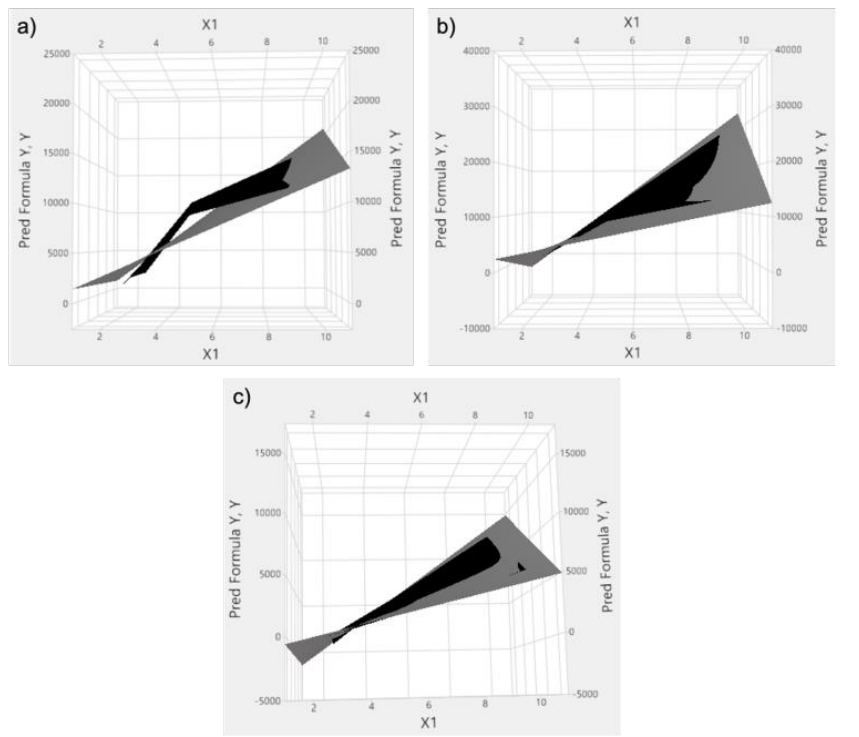
At lower Bis concentrations, the regression model was dominated by the effects of AAm (X 1 ) and SiNP (X 3 ) at a significance threshold of 0.1 ( p = 0.1), as deviation from linearity is characterized by an R 2 value of 0.86 (Figure 2a). At higher Bis concentration, the regression model was dominated by the effects of AAm (X 1 ), Bis (X 2 ), and their respective interaction (X 1 × X 2 ) ( p = 0.1), characterized by an adequate coefficient of determination of 0.97. For the former, the effect of curvature could be observed in the mid-section of the surface plot due to the gap between the experimental data and predicted model (Figure 2a). For the latter, the superimposition of the empirical and theoretical was seamless, except for the lower limit region of the AAm (2.5%) (Figure 2b).